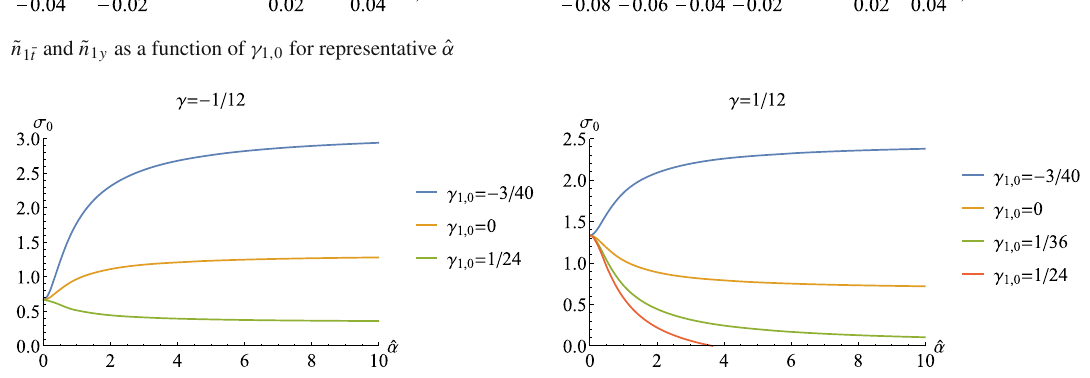
Fig. 18 The DC conductivity as a function of ˆ α when both γ 1 , 0 and γ are turned on